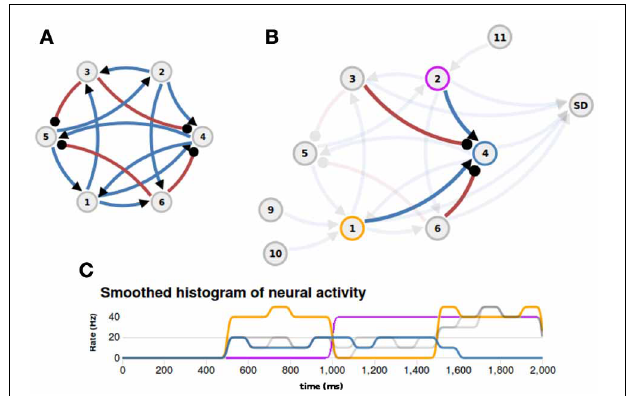
FIGURE 4 | Example (XOR function). (A) The layout of the network that implements a XOR function (blue: excitatory connections, red: inhibitory connections). (B) Appropriate inputs (500–1000ms: Poisson input to N1; 1000–1500ms: Poisson input to N2; 1500–2000ms: Poisson input to N1 and N2) are provided through nodes N9, N10, and N11, and the spiking activity of neuron N4 is measured with a spike detector (SD). The afferent projections to neuron N4 are highlighted. (C) The histogram of neural activity reveals the XOR-function: the activity of ouput neuron N4 (blue line) is high only if one input neuron, N1 (orange line) or N2 (magenta line), is active and is zero